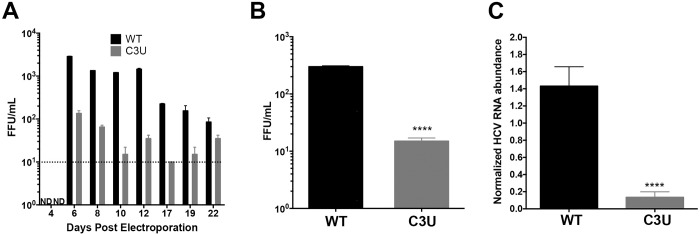
Effects of the C3U single nucleotide substitution on HCV genotype 1a virus production.(A) Extracellular virus production. Huh7.5 cells were electroporated with 10 μg of infectious HCV genotype 1a (H77) RNA that does not (WT) or does contain the C3U mutation. Titers were determined by focus forming assays (FFU). Dotted line indicates threshold of detection. The C3U sample at day 22 may contain a revertant genome. (B) Virus titers of Huh7.5 cells infected with wild-type and C3U H77 variants at a multiplicity of infection (moi) of 0.005 and assayed at 72 hours post infection (**** p<0.0001). (C) RT-qPCR measurement of HCV viral RNA abundance at 5 days post-virus infection at an MOI of 0.005. Data normalized to internal control 18S rRNA levels (**** p<0.0001). Error bars display +/- SD.